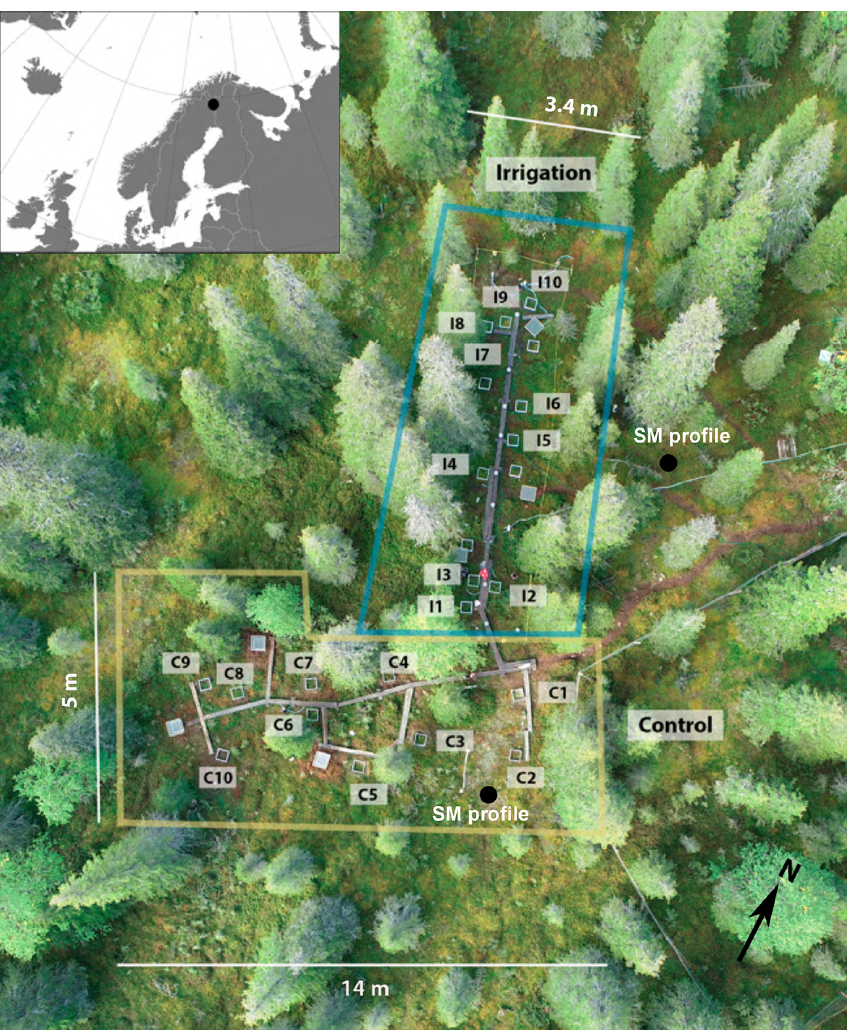
Figure 1. Experimental setup and location of the study site. Aerial image by Bastian Steinhoff-Knopp (Leibniz University Hannover, Septem- ber